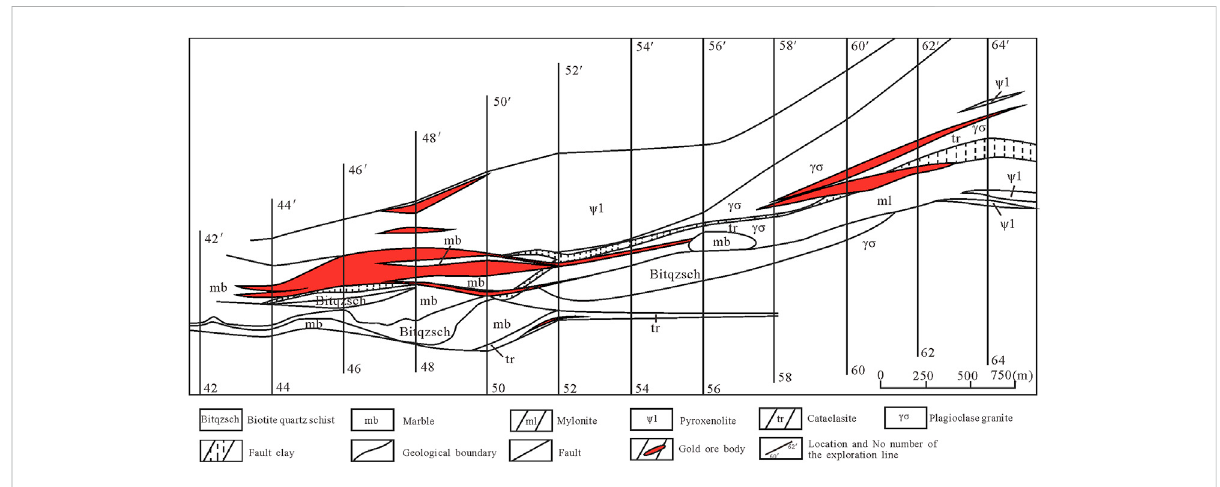
FIGURE 3 Distribution of orebodies in the middle section of the Hongqigou mining